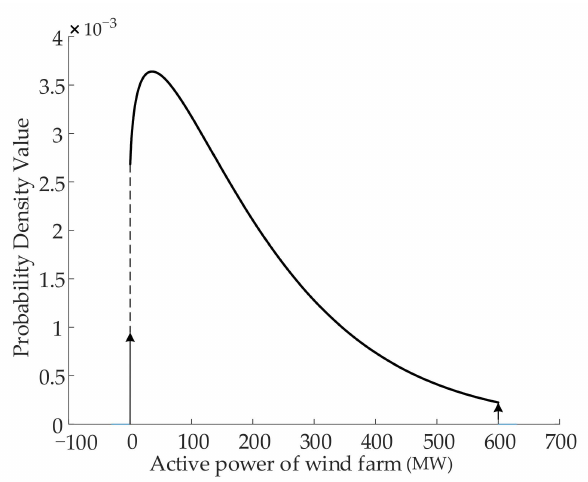
Figure 3. Probability density curve of wind farm active power